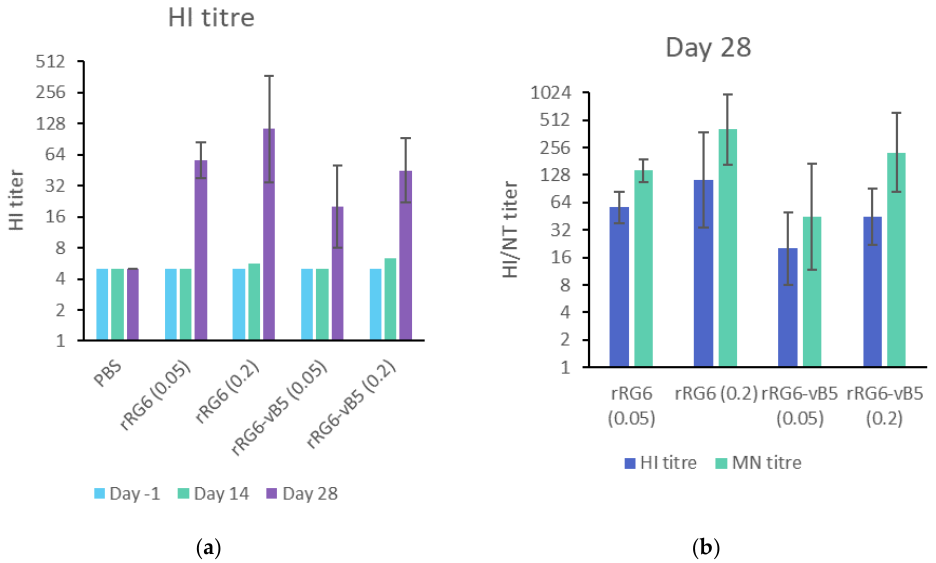
Figure 5. Immunogenicity of multiple RG6 reassortant vaccine viruses in mice. ( a ) Geometric mean titer (GMT) of serum HI antibody in mice receiving different vaccination dosages of RG6 antigens; ( b ) serum HI and neutralization GMT of immunized mouse sera at D28 (14 days after the second immunization). The error bar represents the 95% confidence intervals of GMT.